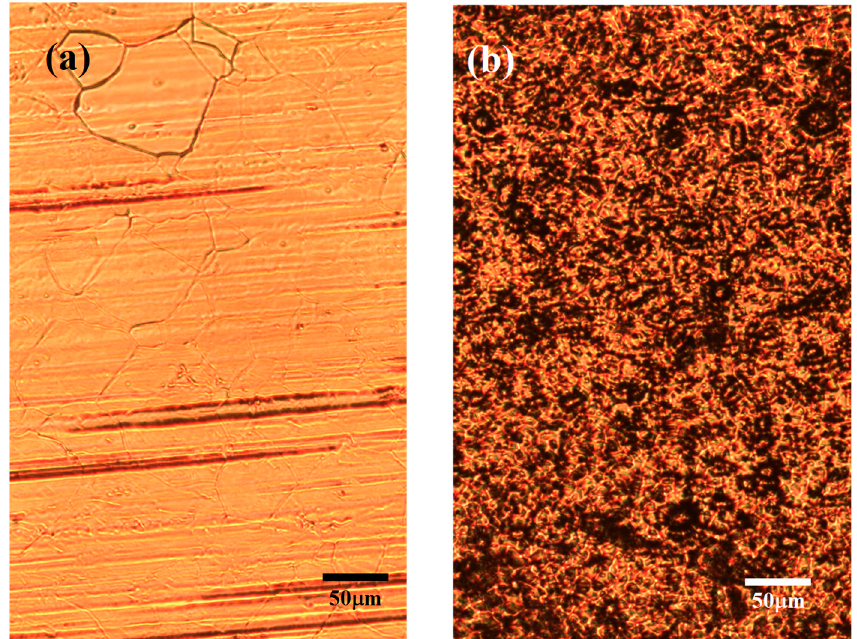
Figure 10. Optical photomicrographs of the copper foil substrate after optimal graphene growth with pretreatment atmosphere of ( a ) H 2 /Ar and ( b ) Ar compositions, respectively.